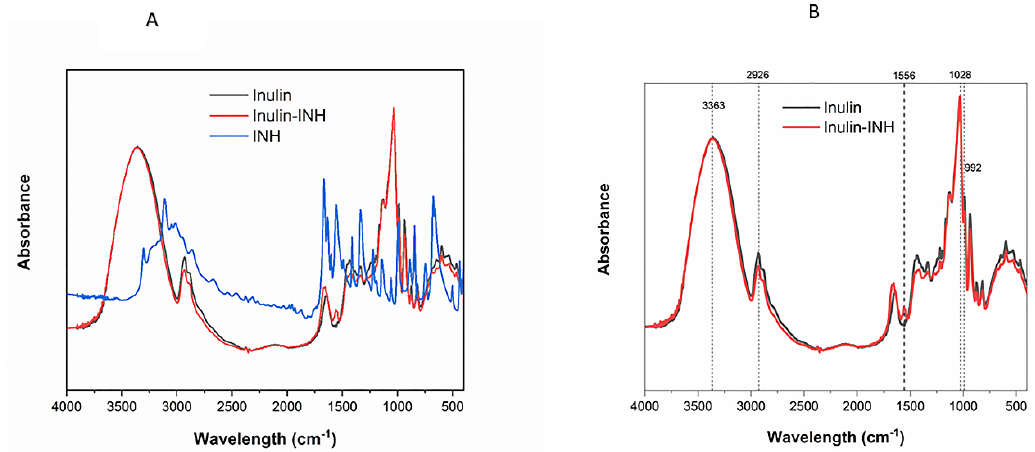
Figure 2. Fourier transform infrared spectroscopy (FTIR) spectra of inulin, conjugate, and INH ( A ) and inulin and conjugate ( B ).